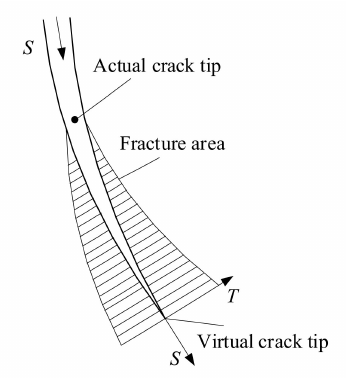
Figure 14. Virtual crack model.